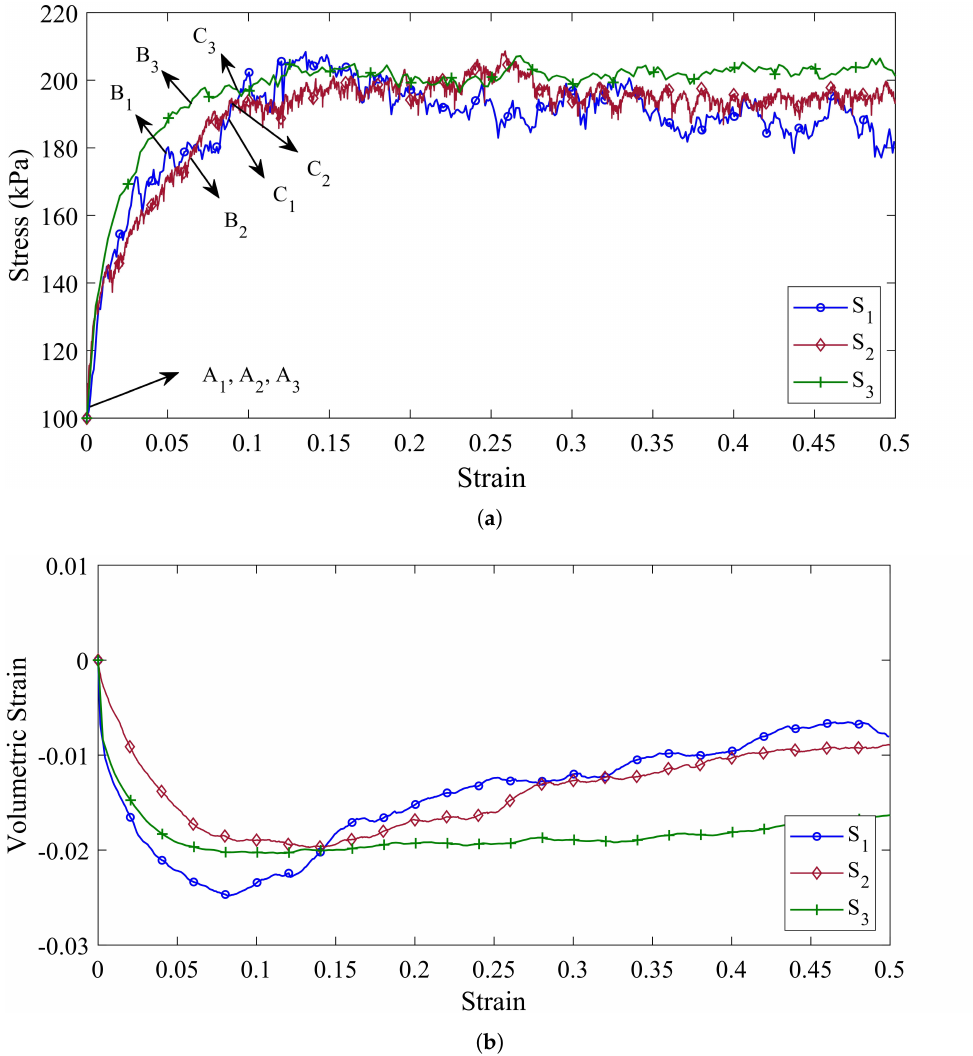
Figure 5. ( a ) The shear stress behavior and ( b ) the volumetric strain behavior of the specimens with different particle size distribution and without the rolling resistance ( η r = 0) (Specimen S 1 is composed of 4–8 US Mesh coke particles, specimen S 2 is composed of 4–8 US Mesh and 8–14 US Mesh coke particles, and specimen S 3 is composed of 4–8 US Mesh, 8–14 US Mesh, and 14–30 US Mesh coke